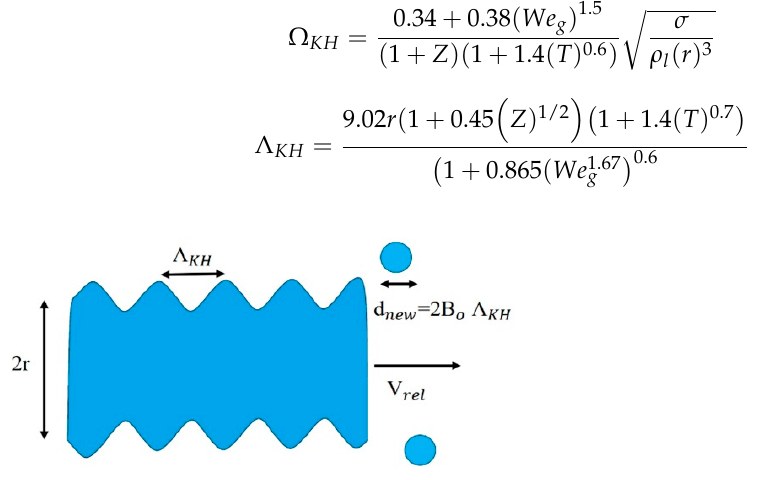
Figure 2. Schematic of KH instabilities.